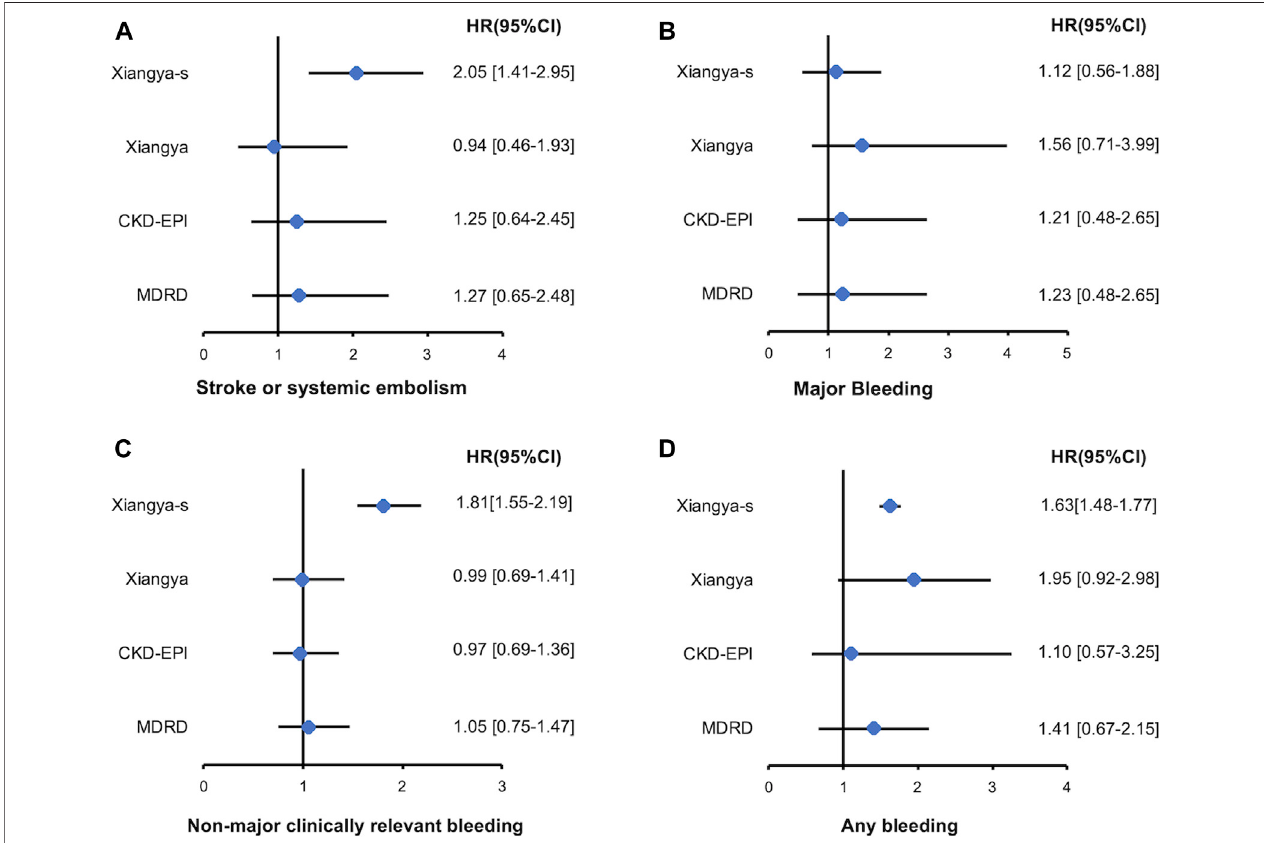
FIGURE 4 | Stroke or systemic embolism (A) , major bleeding (B) , non-major clinically relevant bleeding (C) , and any bleeding (D) events associated with re- classi fi edtoahigher orlowerrenalfunctionstagesbyMDRD,CKD-EPI,XiangyaandXiangya-sequationcompared withCGequationinpatientswitheCrCl < 50 ml/min. eCrCl, estimated creatinine clearance; CG, Cockcroft-Gault; MDRD, Modi fi cation of Diet in Renal Disease; CKD-EPI, Chronic Kidney Disease Epidemiology